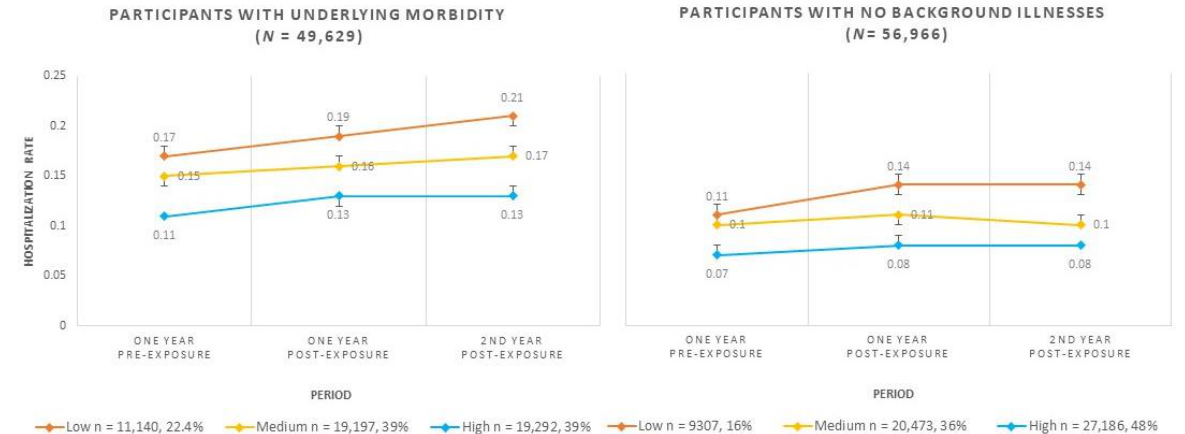
Figure 1. Hospitalization rates by SES and morbidity status based on estimated means of Poisson regression during the study period